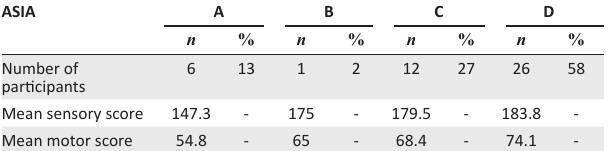
TABLE 1: American Spinal Injury Association classification motor and sensory